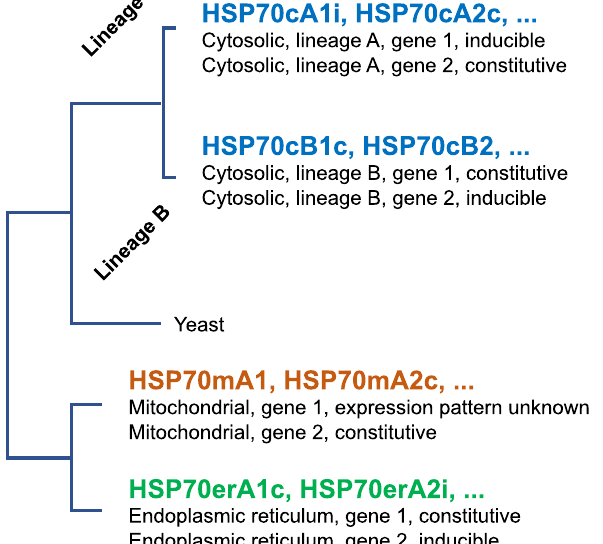
Figure 5. A proposed new nomenclature for HSP70 family